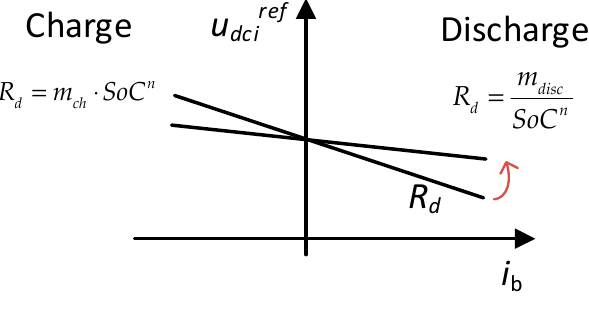
Figure 3. SoC-based droop control used in the DC SMG.